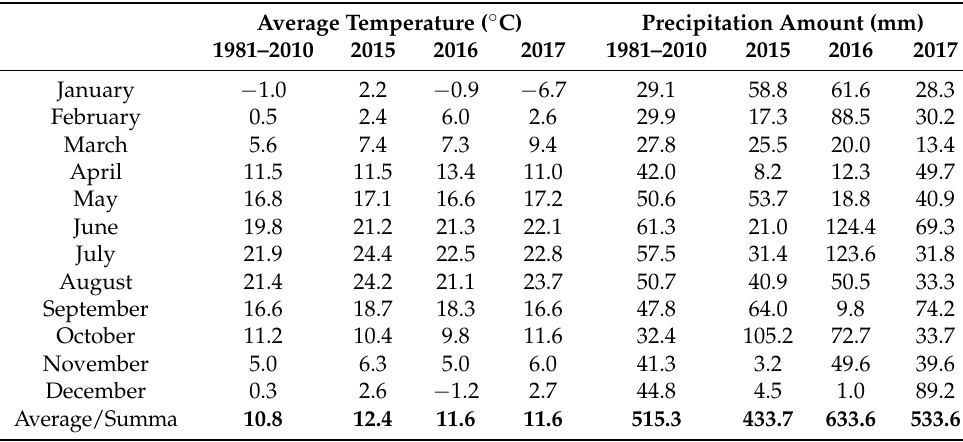
Table 1. Meteorological data of 2015–2017 during the irrigation